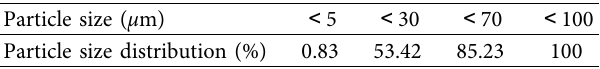
Figure 1: Appearance of experimental materials. Table 1: Particle size distribution of steel slag